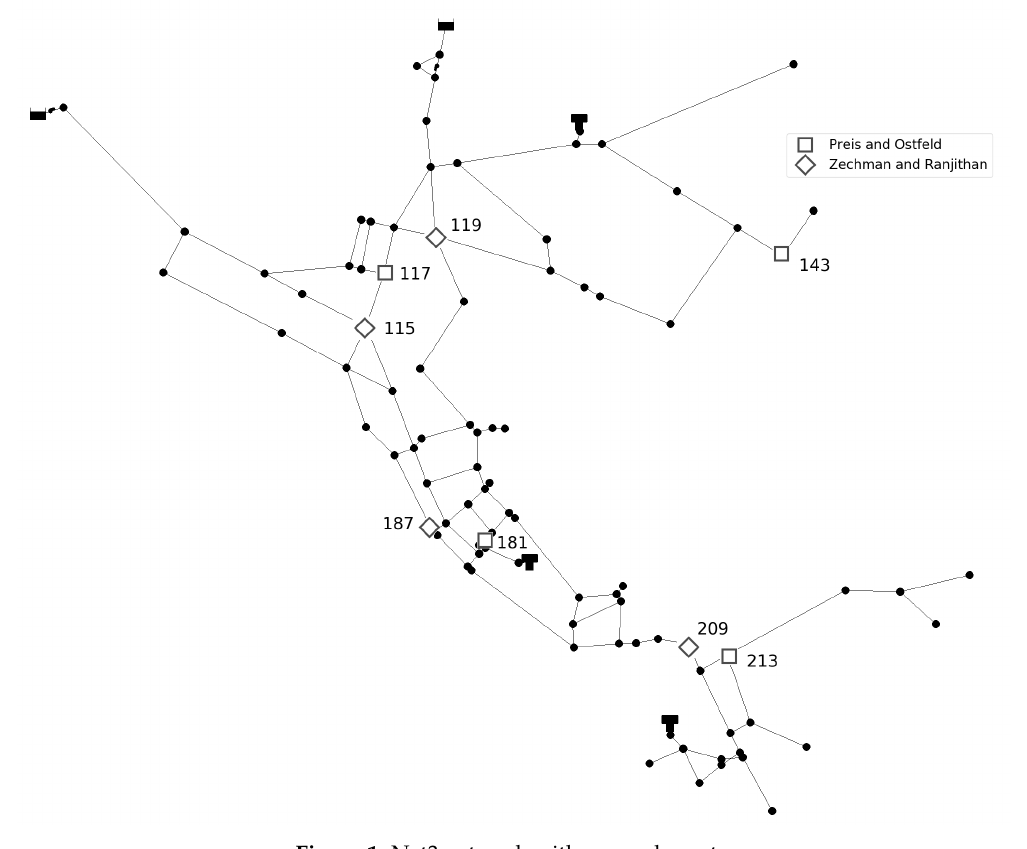
Figure 1. Net3 network with sensor layouts.